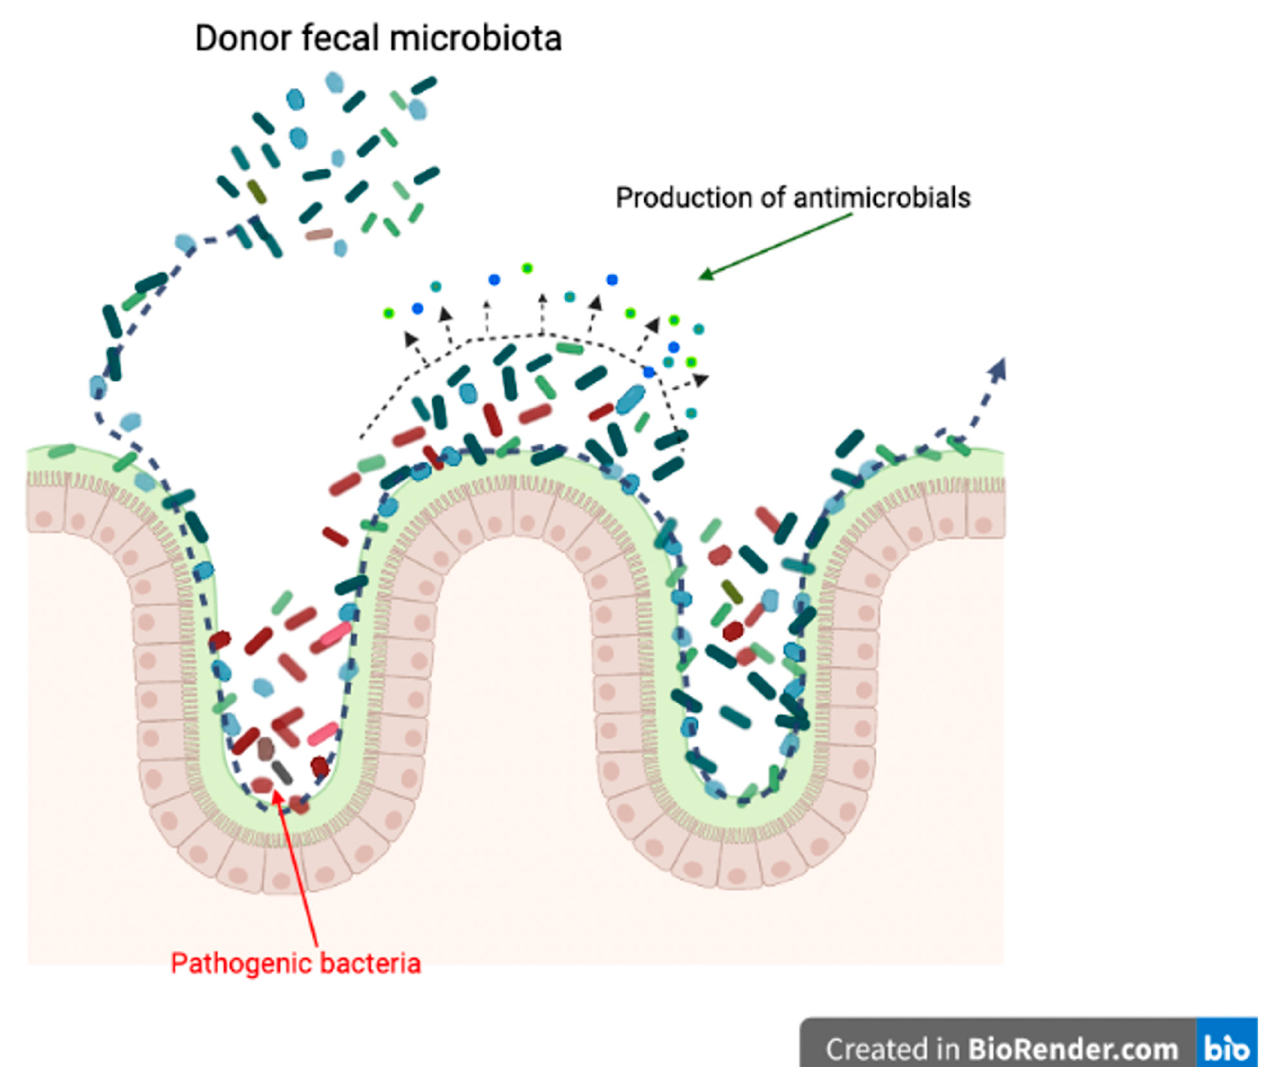
Figure 4. Potential mechanism of FMT; production of antimicrobials. (Created with BioRender.com, accessed date 18 June